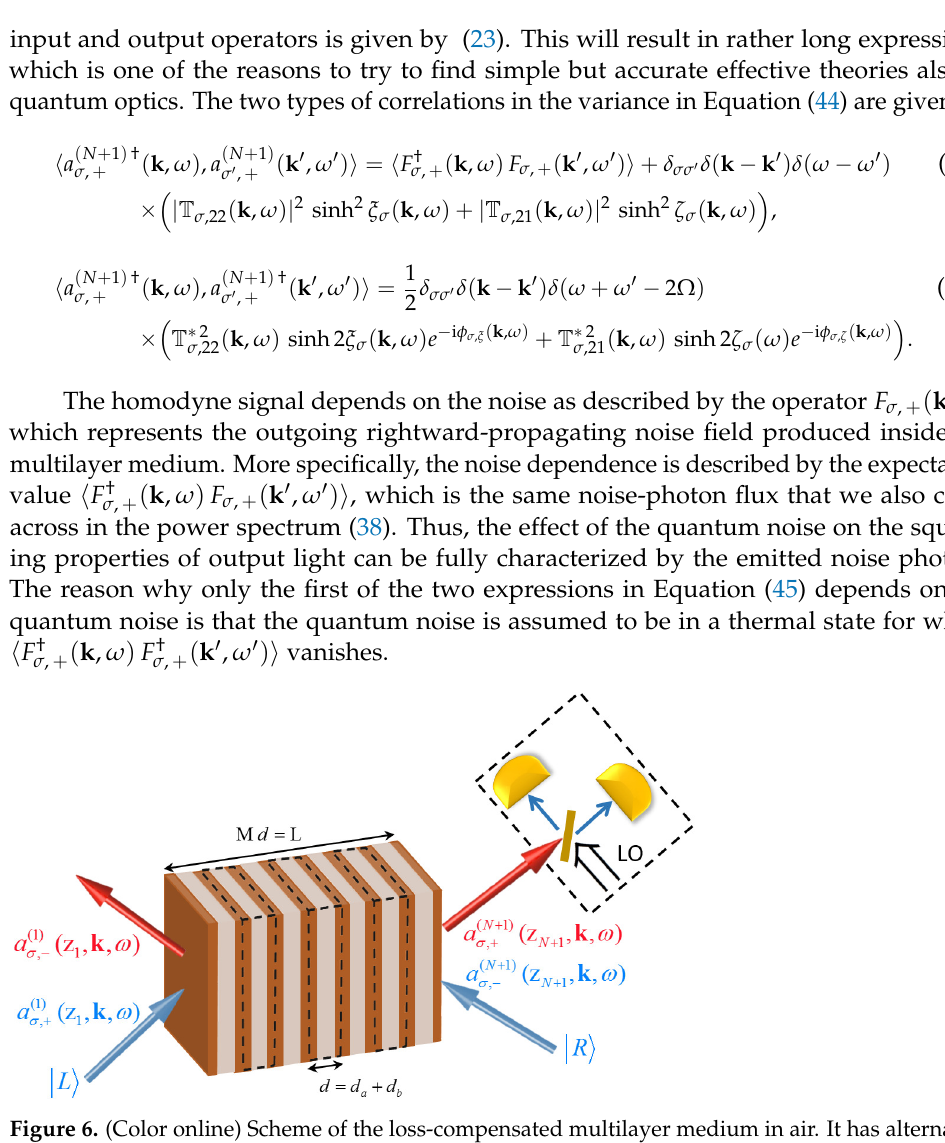
Figure 6. (Color online) Scheme of the loss-compensated multilayer medium in air. It has alternating layers with thicknesses d a,b that are arranged symmetrically. The two outermost layers have widths d a /2, which makes the medium finite periodic with M unit cells. The amplifying and absorbing layers are described by the Lorentz model (Equation (40)), with parameters ω p / ω 0 = 0.3, γ a / ω 0 = 0.1 for a the lossy layers, and ω p / ω 0 = 0.25, γ b / ω 0 = 0.15 for the layers with gain. We choose d a,b ω 0 / c = 0.1 b L and M = 5. The incident squeezed vacuum state has the squeeze strength ζ σ = 0.2 and phase | (cid:105) 5 R φ σ , ζ = 2 φ σ ,LO , while the squeezed vacuum state has the same strength ξ σ = 0.2 with 2 − | (cid:105) φ σ , ξ = 2 φ σ ,LO 2, all assumed to be frequency independent. The outgoing light on the right-hand − side of the multilayer metamaterial is measured with a balanced homodyne detector, shown within the dashed box, which is assumed to co-rotate with the exit